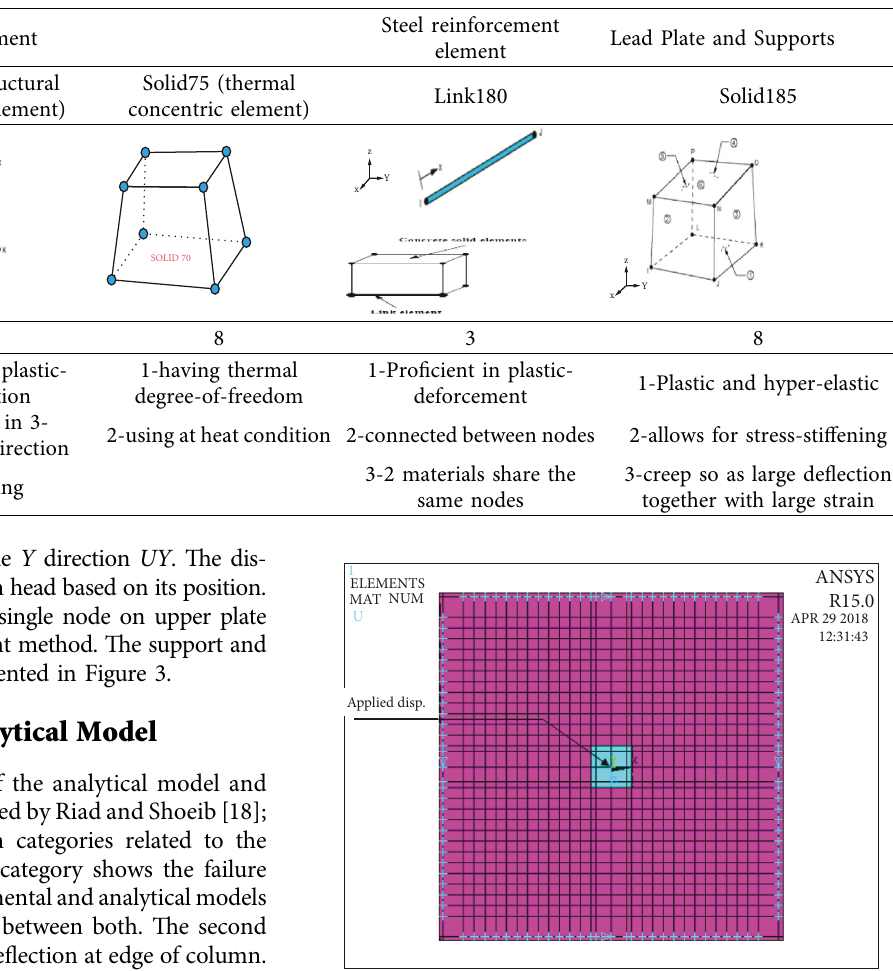
Table 1: Summary for the elements needed at modeling.